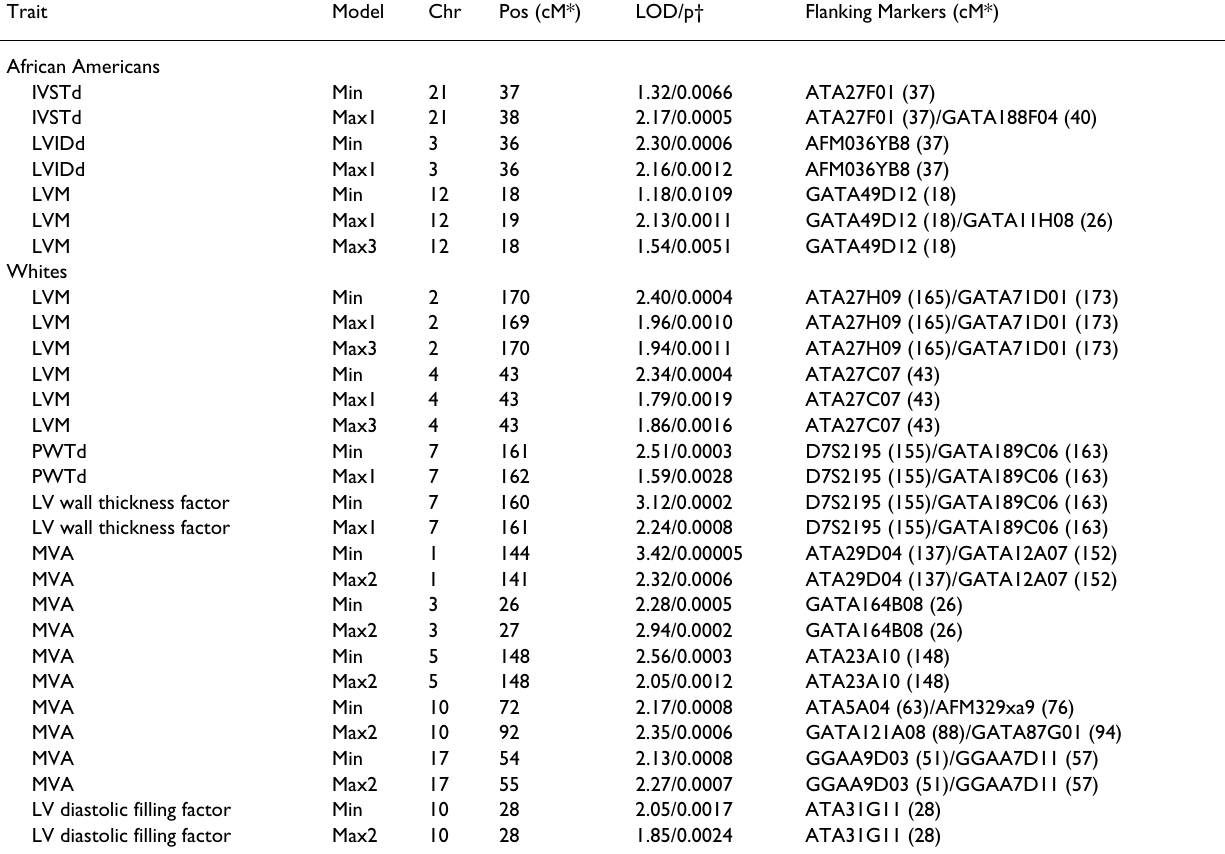
Table 5: Peak Multipoint LOD Scores and Flanking Markers for Regions with LOD > 2.0 from at Least One Adjustment Model in African Americans and Whites